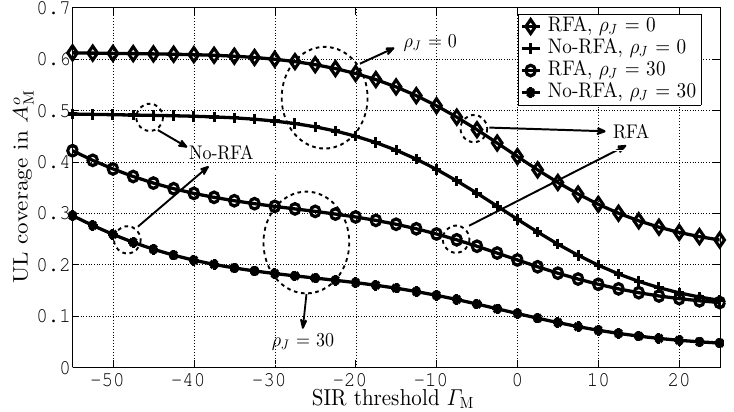
Figure 3. UL coverage versus Γ M in A o